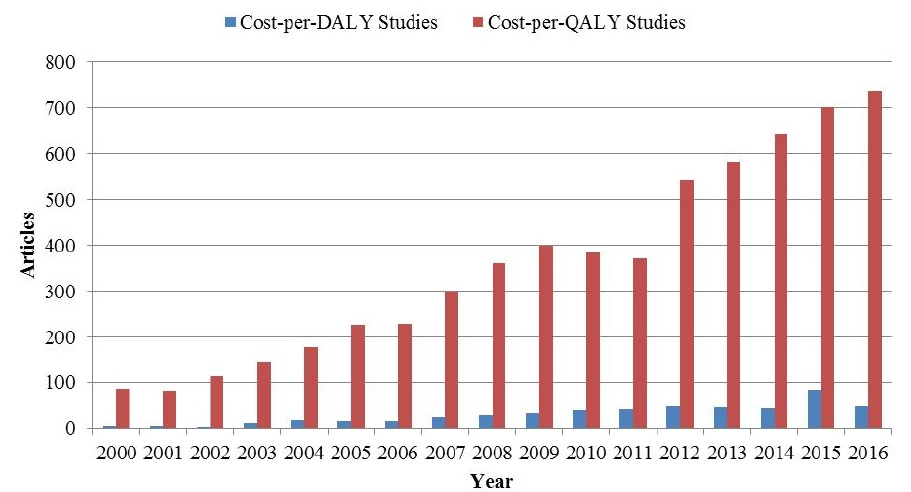
Figure 1. Published cost-per-DALY and cost-per-QALY studies by year. Journals published 360 cost-per-QALY studies during the years 1976 through 2000. Journals published 13 cost-per-DALY studies during the years 1995 through